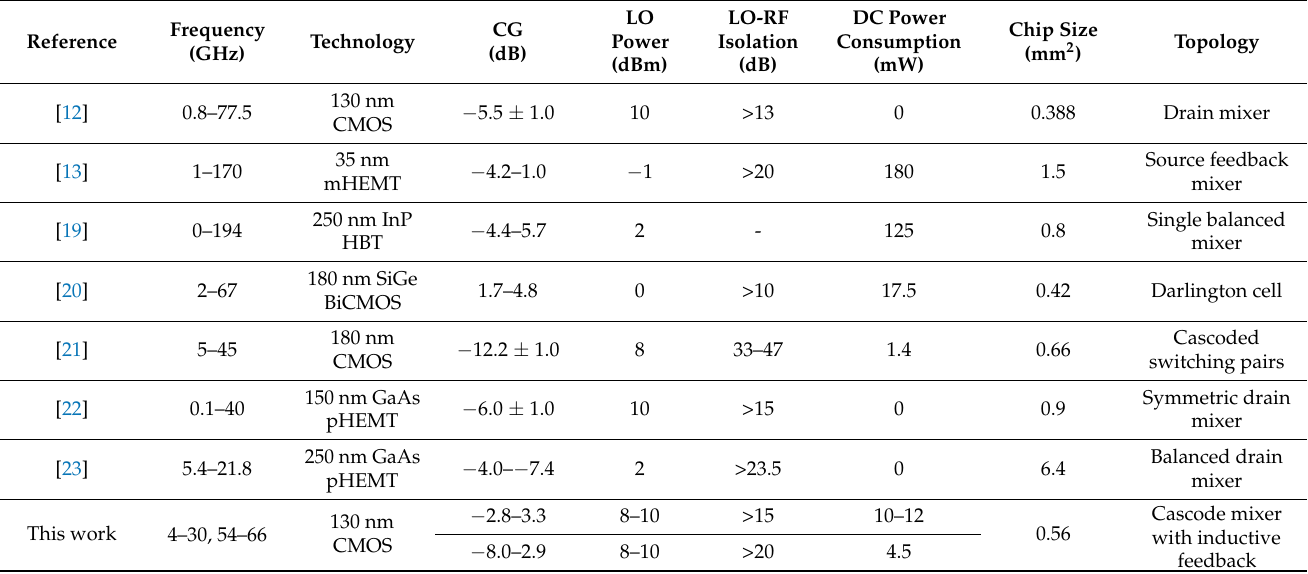
Table 2. Performance comparison of distributed